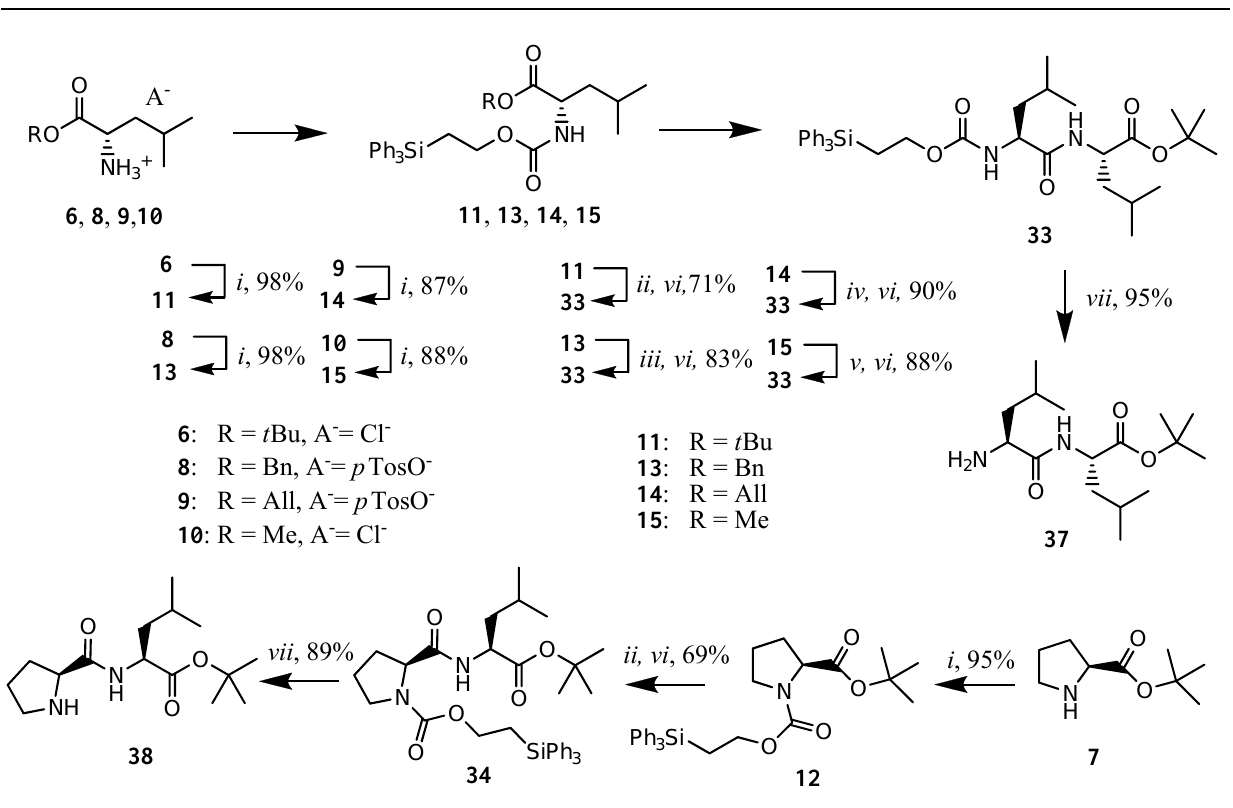
Scheme 2. Synthesis and testing of Tpseoc-derivatives of L-leucine- and L-proline